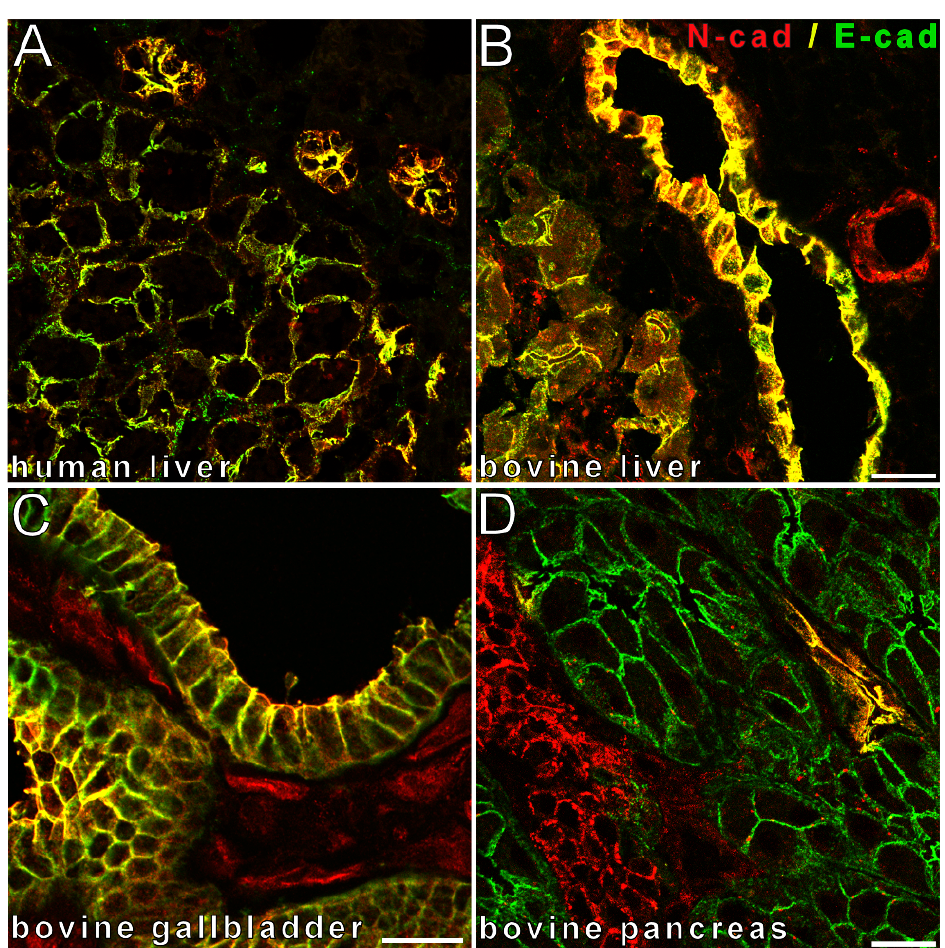
Figure 1. Colocalization of E ‐ and N ‐ cadherin is conserved in normal epithelia of the pancreatobiliary tract. Double ‐ label laser scanning immunofluorescence microscopy shows complete colocalization (resulting in yellow color in the merge images) of E ‐ cadherin (E ‐ cad, Alexa 488, green), with N ‐ cadherin (N ‐ cad, cy3, red) in small bile ducts in normal human liver ( A ), in a large bile duct in normal bovine liver ( B ), as well as in bovine gallbladder epithelium ( C ) and pancreatic duct epithelium in normal bovine pancreas ( D ). Note the colocalization of E ‐ and N ‐ cadherins in normal hepatocytes ( A , B ), the positivity of vessels for only N ‐ cadherin but not E ‐ cadherin ( B , C ), E ‐ cadherin ‐ positivity with N ‐ cadherin ‐ negativity in pancreas acini ( D ), and differential N ‐ and E ‐ cadherin expression in pancreatic islet cells ( D ). Bar length: 20 μ m.